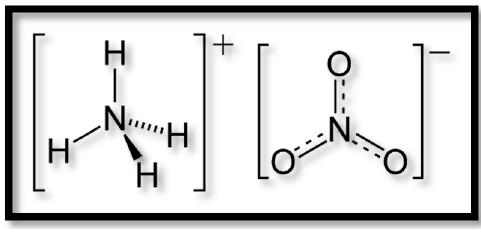
Figure 1. Formula of ammonium nitrate.